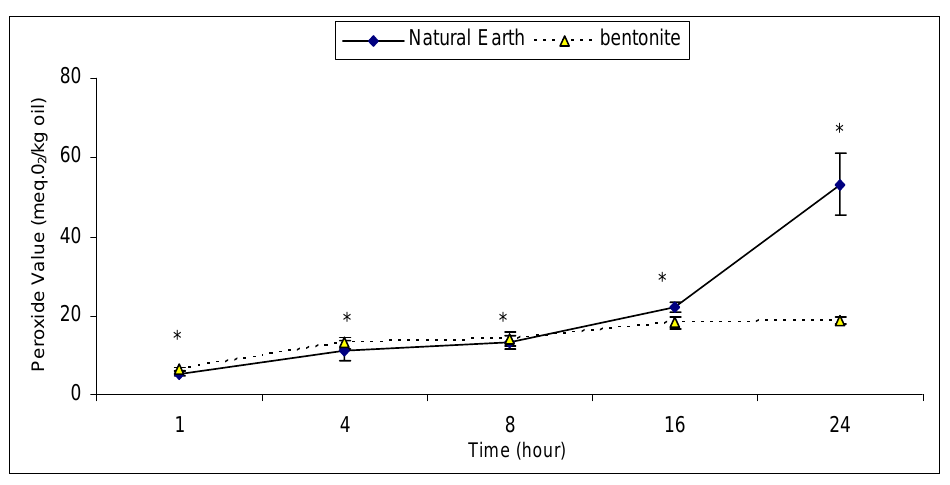
Figure 2. Effective bleaching time of crude ostrich oil using bentonite and natural earth clay in removing